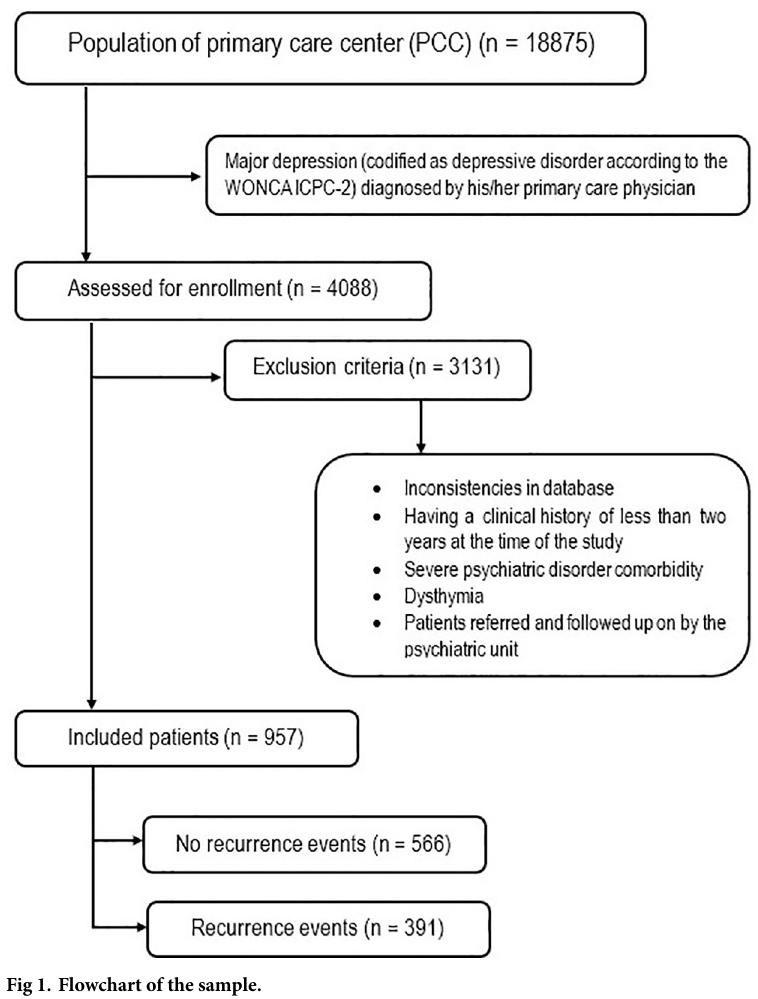
Fig 1. Flowchart of the